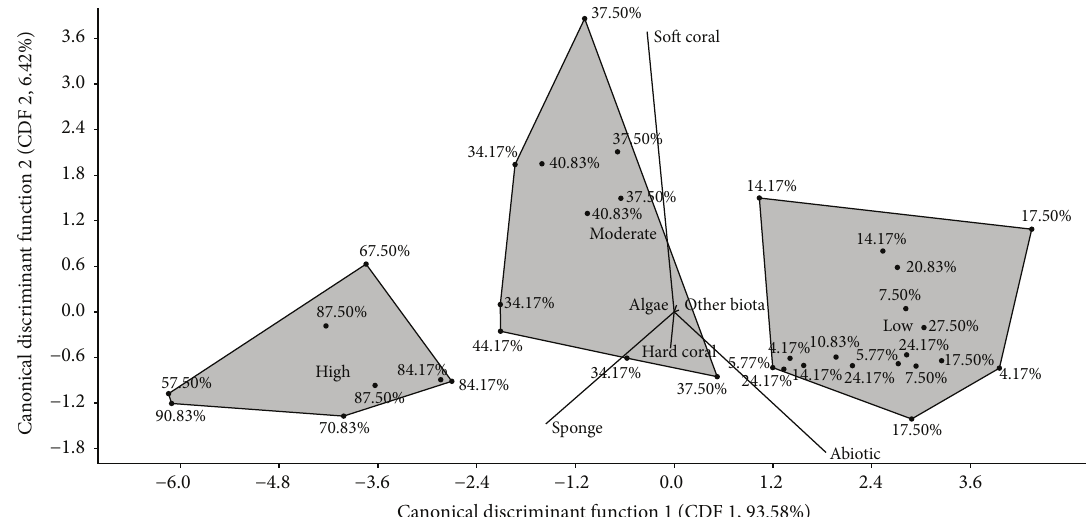
Figure 5: Score plot of CDA with sponges local coral cover as a variables to the sponges bioactivity, high (BSLT activity more than 50% at 100ppm extract), moderate (BSLT activity between 30 and 50% at 100 ppm extract), and low (BSLT activity lower than 30% at 100ppm